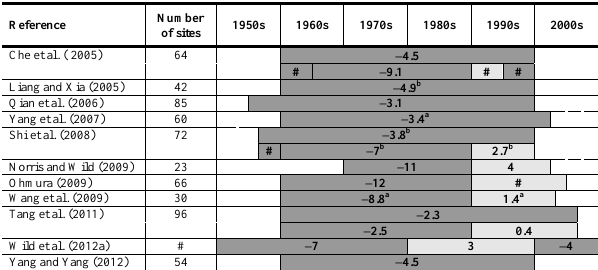
Table 1. Magnitudes of trends in surface solar radiation (W m − 2 decade − 1 ) in China. Note that # denotes value not provided, a is original value converted into common unit of Wm − 2 decade − 1 , and b is value estimated by Wild (2009). Dark grey bars are for dimming trend and light grey bars for brightening trend.